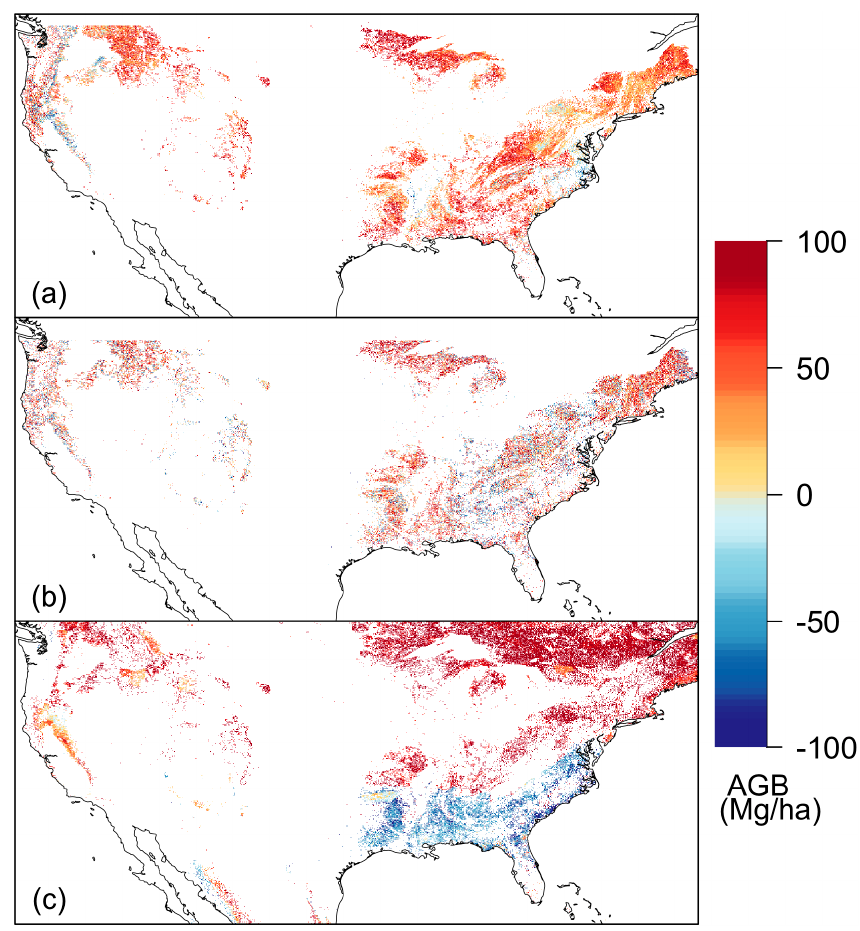
Figure 13. The difference map between our global wall-to-wall forest AGB product and the products from ( a ) Blackard et al. (2008) [76]; ( b ) Saatchi et al. (2005) [77]; and ( c ) Reusch & Gibbs (2008) [73] in the U.S. forest area.